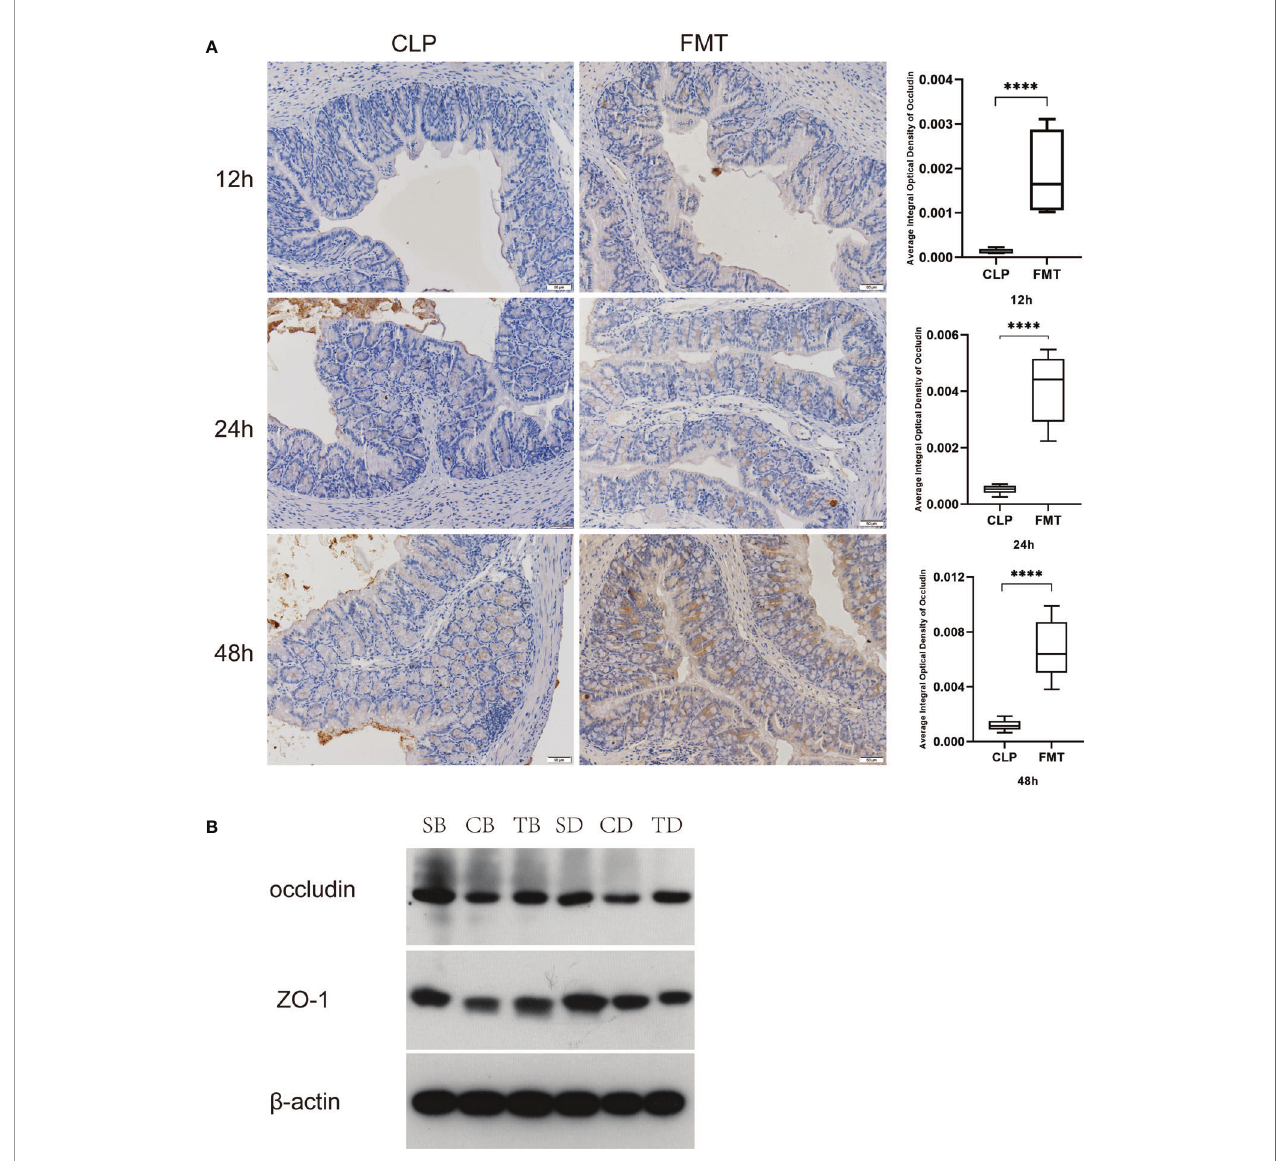
FIGURE 5 | Comparison of tight junction protein expression. (A) Comparison of occluding expression in the CLP and FMT groups at 12, 24 add 48 h, respectively, and observed under a digital microscope (20 × 10). Signi fi cant results are shown in the box plot on the right, **** P < 0.0001; (B) Relative expression of occludin and ZO-1 compared with b -actin expression in the Sham, CLP, and FMT groups at 24 or 48 h. SB, CB, TB, SD, CD, and TD represent the 24 h Sham, CLP, and FMT groups and 48 h Sham, CLP, and FMT groups,